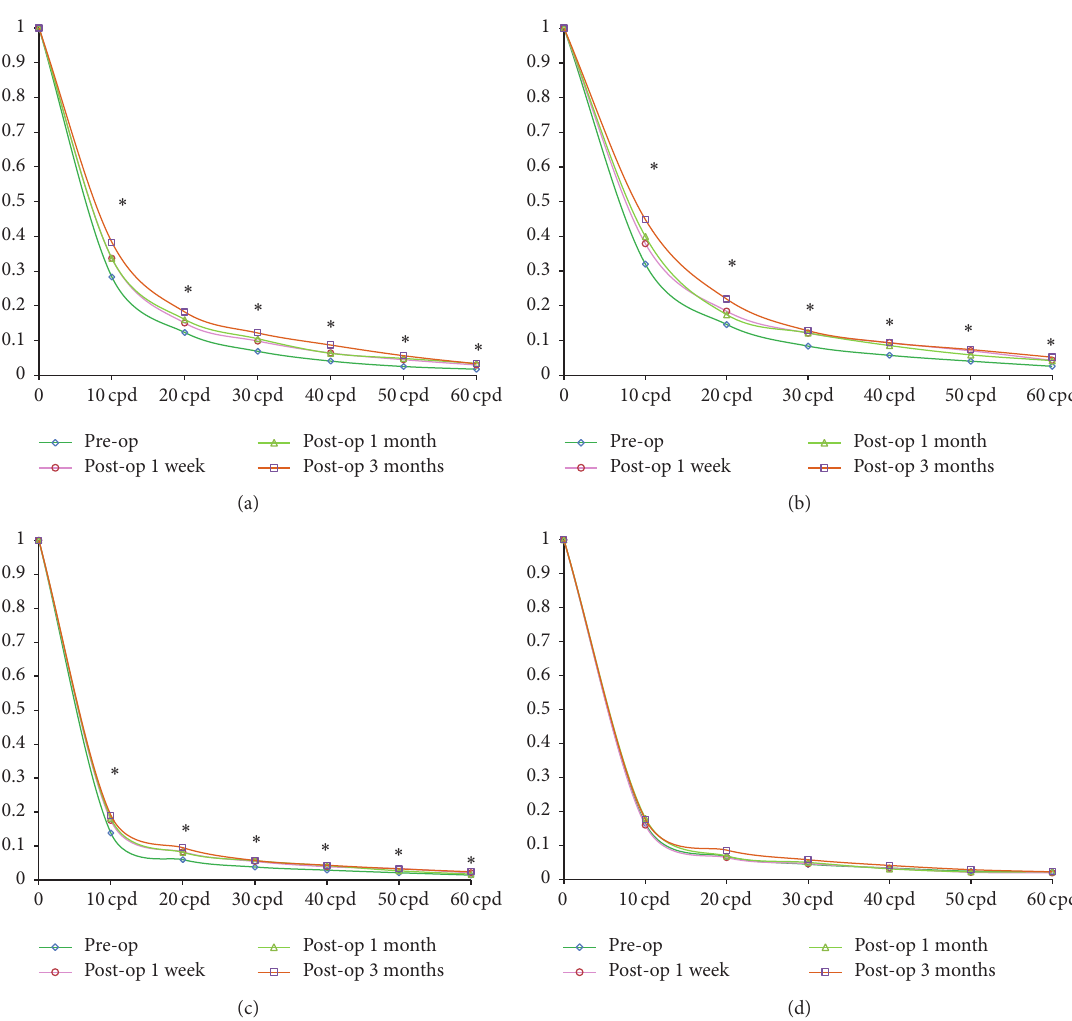
Figure 1: The changes of MTF values before and 1 week, 1 month, and 3 months after SMILE procedure. (a) The change of MTF curve at vertical meridian at 3 mm pupil diameters; (b) the change of MTF curve at horizontal meridian at 3 mm pupil diameters; (c) the change of MTF curve at vertical meridian at 6 mm pupil diameters; (d) the change of MTF curve at horizontal meridian at 6 mm pupil diameters. ∗ Significant difference among different follow-up